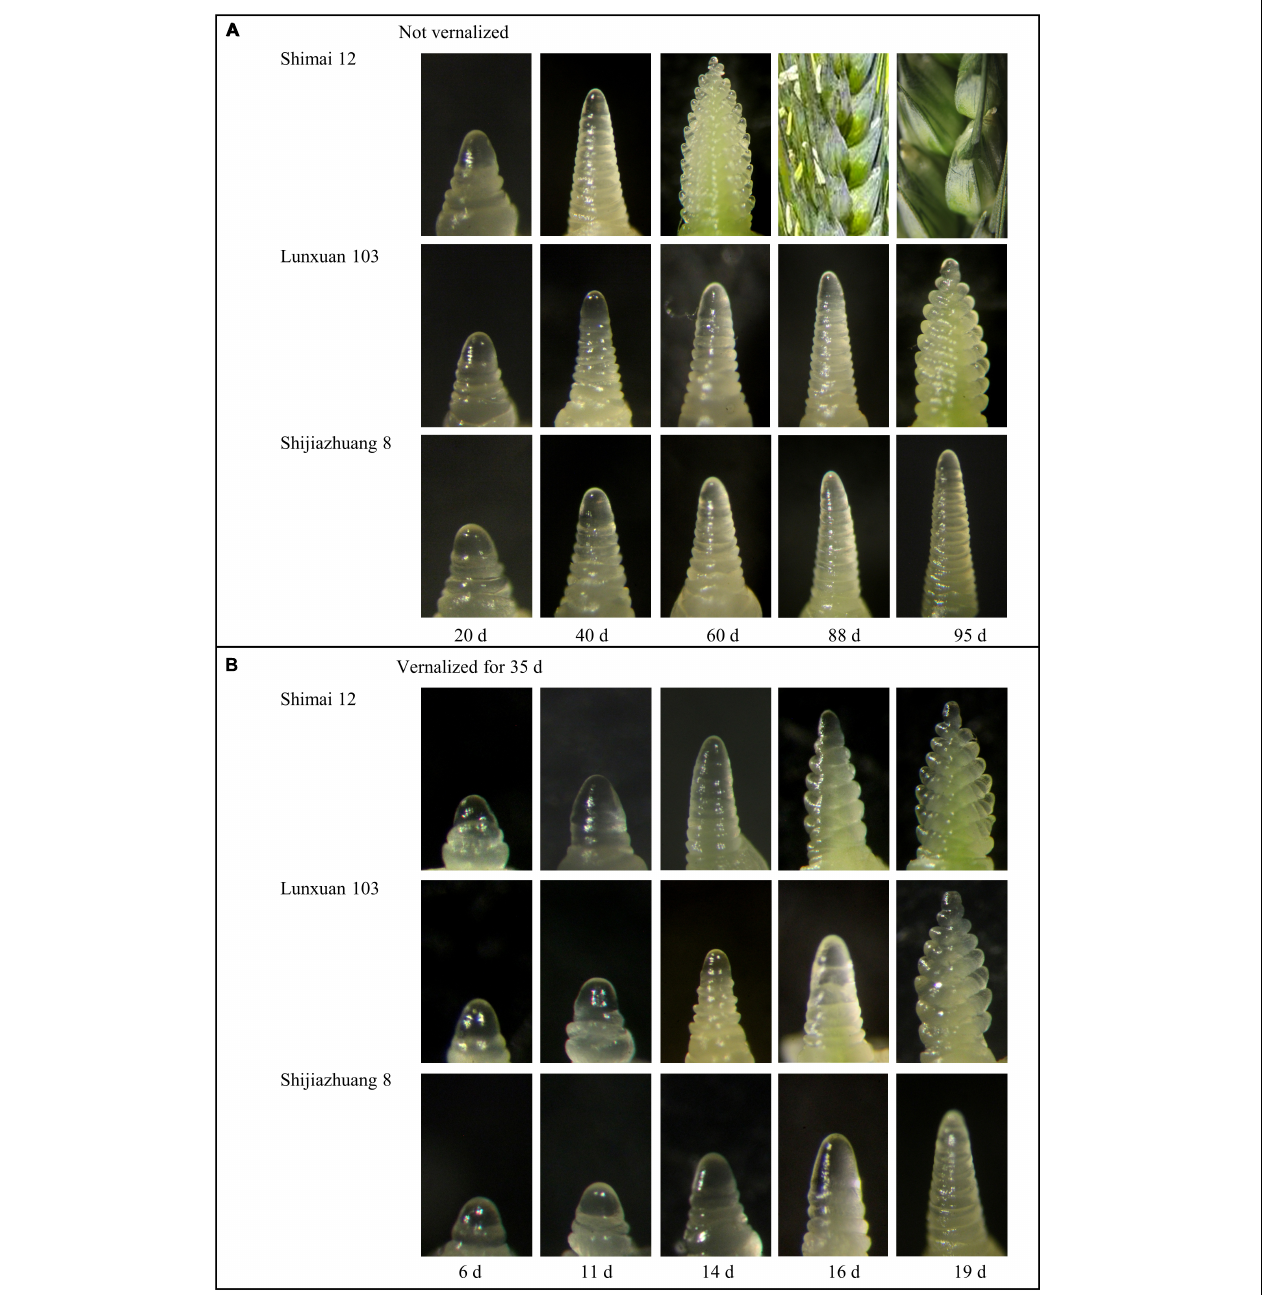
FIGURE 1 | Inflorescence development of Lunxuan 103 and its parents, Shijiazhuang 8 and Shimai 12, with vernalization for 0 d (A) and 35 d (B) followed by growth under 16 h day length at 22 ◦ C and 8 h dark length at 18 ◦ C.